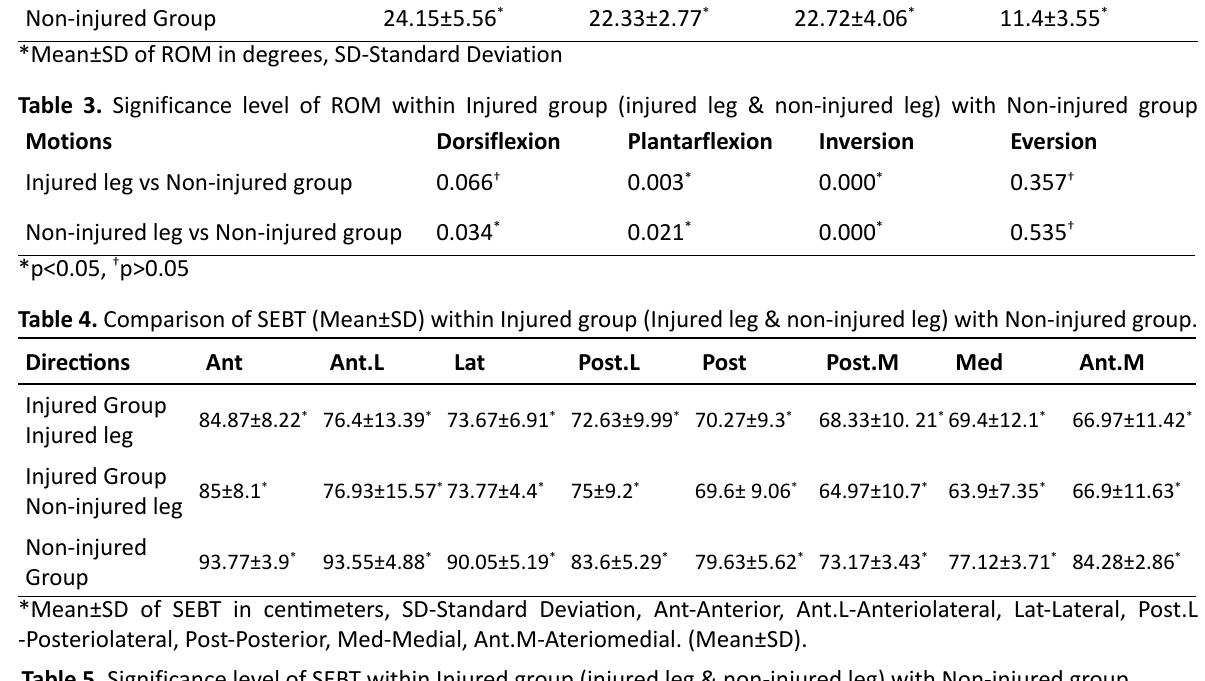
Table 5. Significance level of SEBT within Injured group (injured leg & non-injured leg) with Non-injured group.